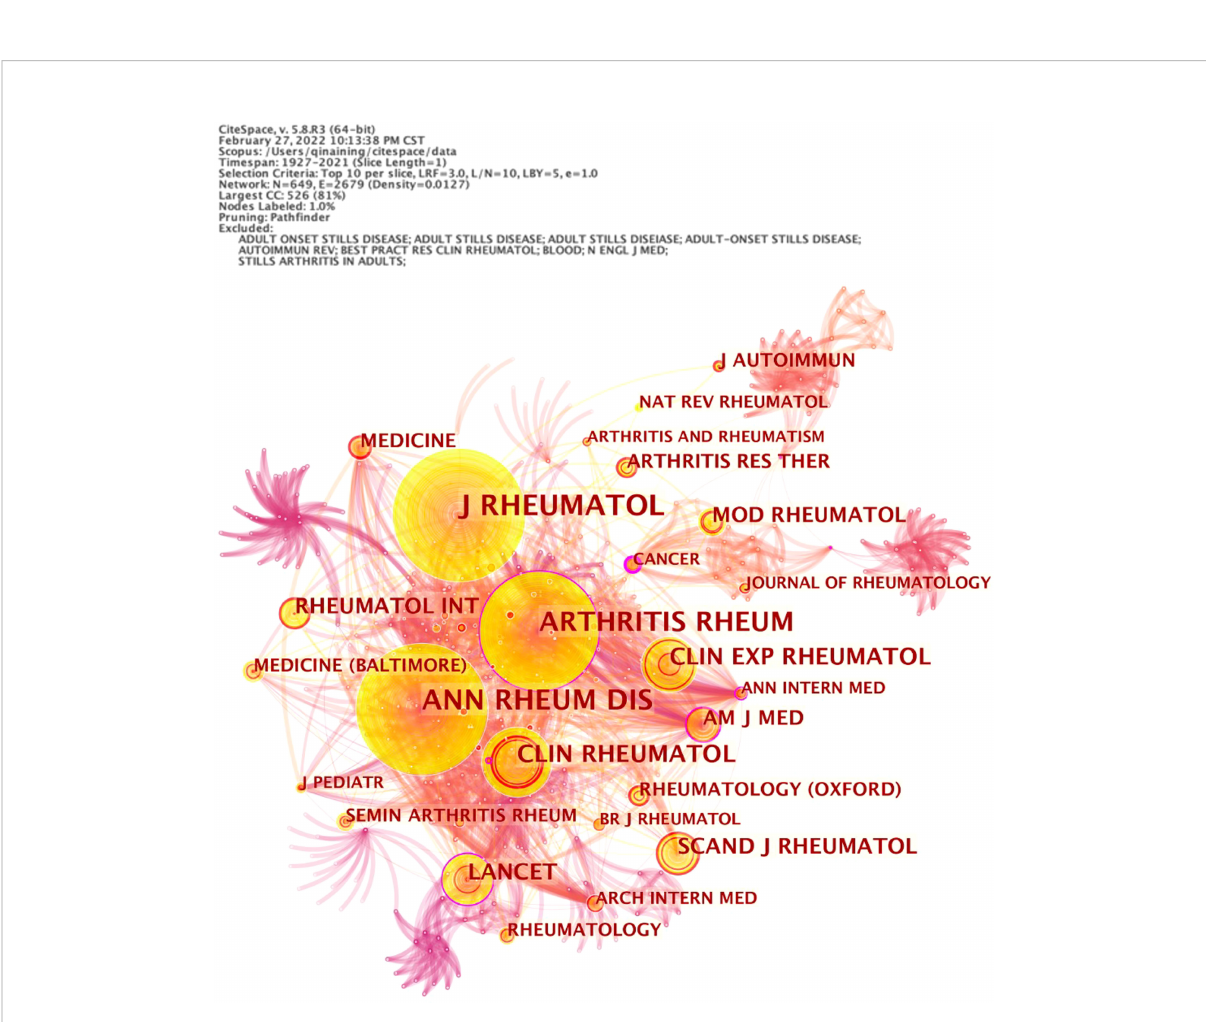
FIGURE 2 The co-citation network of adult-onset Still ’ s disease articles from 1921 to 2021.